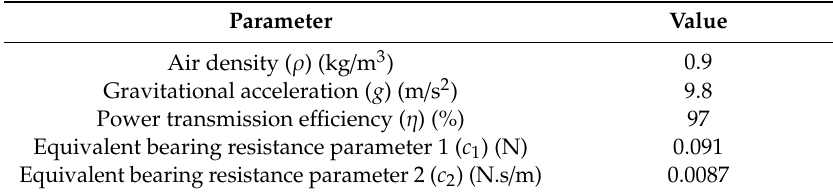
Table 3. Constants used for the computation of total race